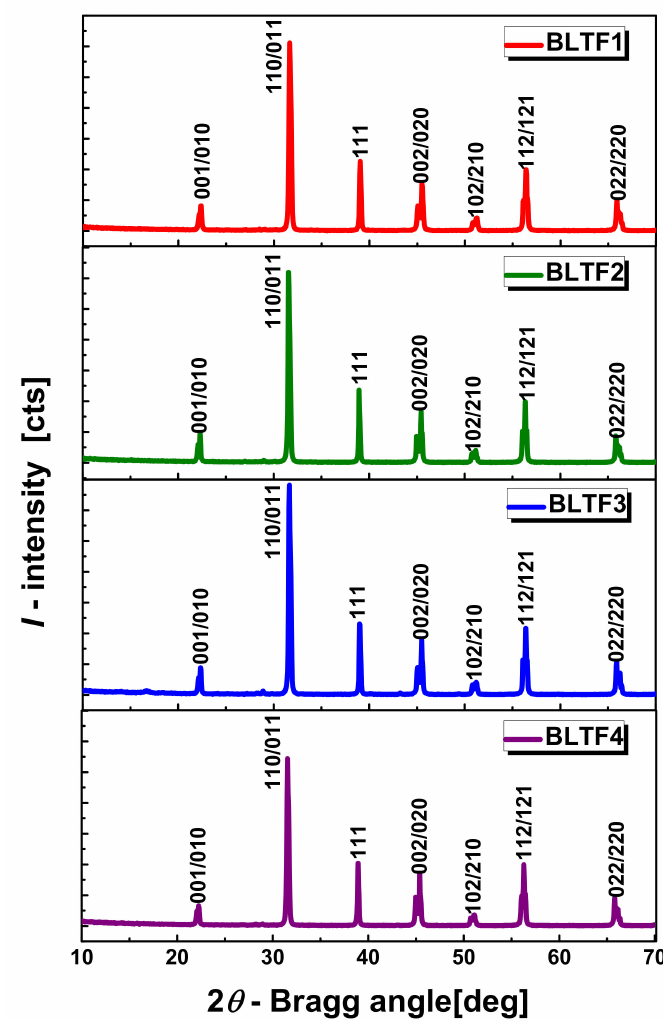
Figure 3. X-ray di ff raction patterns measured at room temperature for BLTF ceramics.